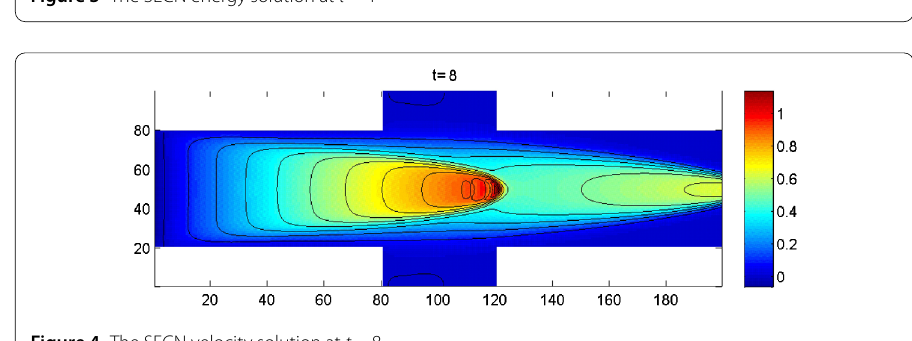
Figure 3 The SECN energy solution at t = 4